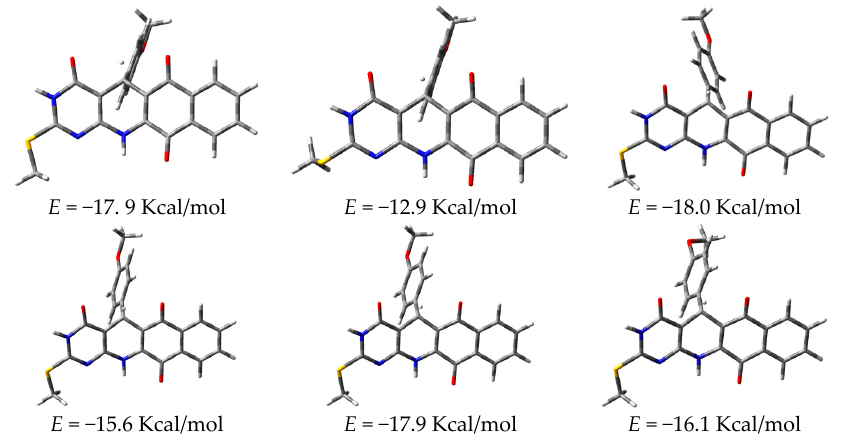
Figure 5. Highest and lowest energy conformations using DFT/B3LYP/6-31G(d,p) for 5-(4-methoxyphenyl)-2-methylthio-5,12-dihydrobenzo[ g ]pyrimido[4,5- b ]quinoline-4,6,11(3 H )-trione 4c .